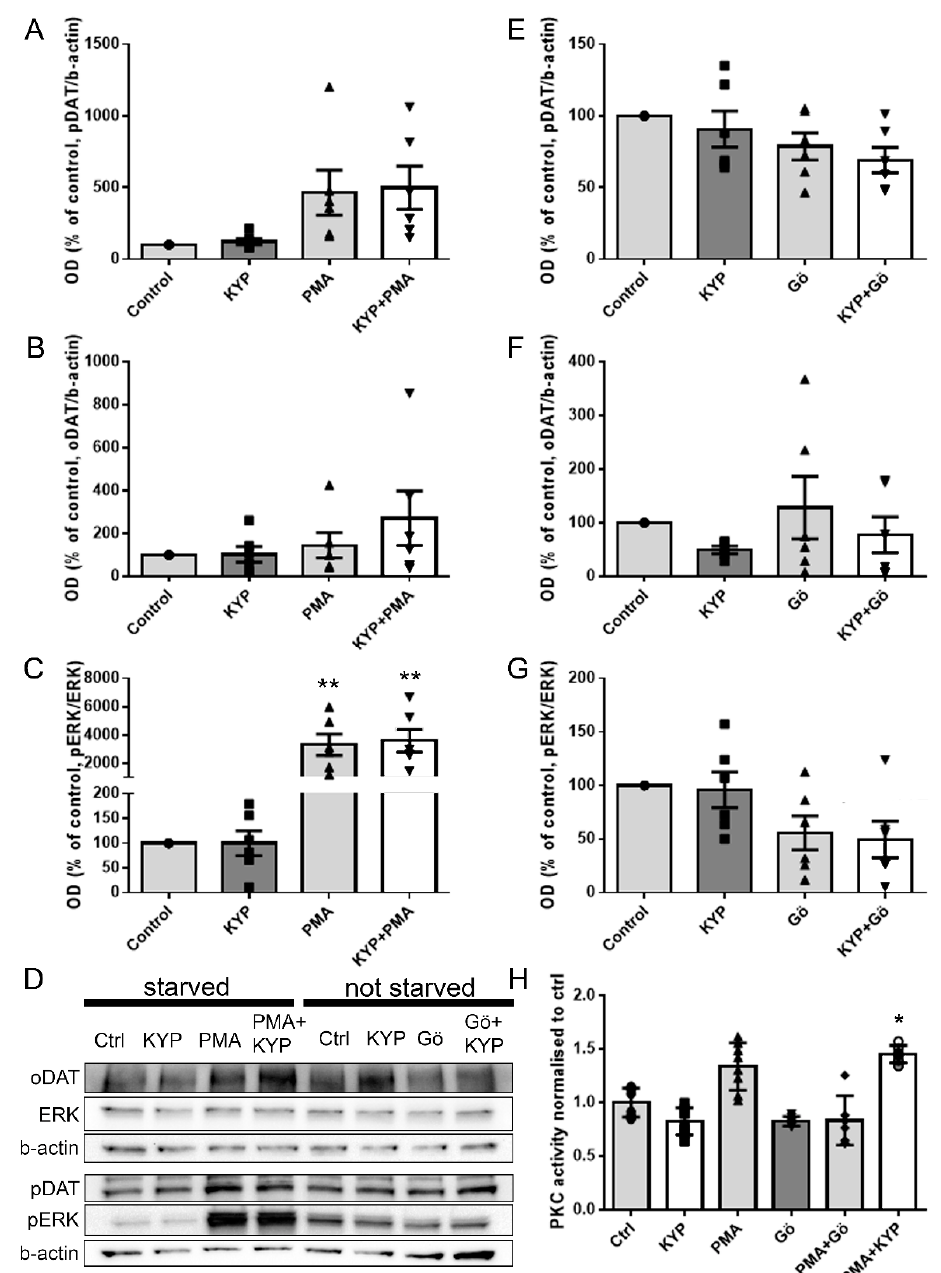
Figure 3. The effect of PREP inhibitor KYP-2047 alone or in combination with PKC activator PMA or inhibitor Gö-6983 on phosphorylation of DAT and ERK, oligomerization of DAT, and PKC activity in HEK-293 cells. DAT, pDAT, ERK, and pERK were measured by WB in Wt HEK-293 cells transfected with DAT. Cells were starved in serum-free media for 2 h before 1 µM KYP, 1 µM PMA, or 1 µM KYP + 1 µM PMA treatment for 30 min ( A – C ); or treated with 1 µM KYP, 1 µM Gö-9683, or 1 µM KYP + 1 µM Gö-6983 for 30 min without starving ( E – G ). Optical-density values were normalized to the loading control ( β -actin) optical density. Representative WB figures for ( A – C ) and ( D – F ) are presented in panel ( G ). PKC activity assay was performed on HEK-293 cells treated with 0.1% DMSO (Ctrl), 10 µM KYP, 100 nM PMA, 1 µM Gö-6983, KYP 10 µM KYP + 100 nM PMA, or 1 µM Gö-6983 + 100 nM PMA for 30 min in FBS-free medium ( H ). Squares, triangles and circles in the Figure present individual data points. Data were collected from six WBs that had samples from six independent cell culture preparations. PKC activity assay data are from three independent experiments for cells with two biological replicates. Bars represent mean ± SEM. * p < 0.05, ** p < 0.01, one-way ANOVA, Tukey´s post-hoc test.